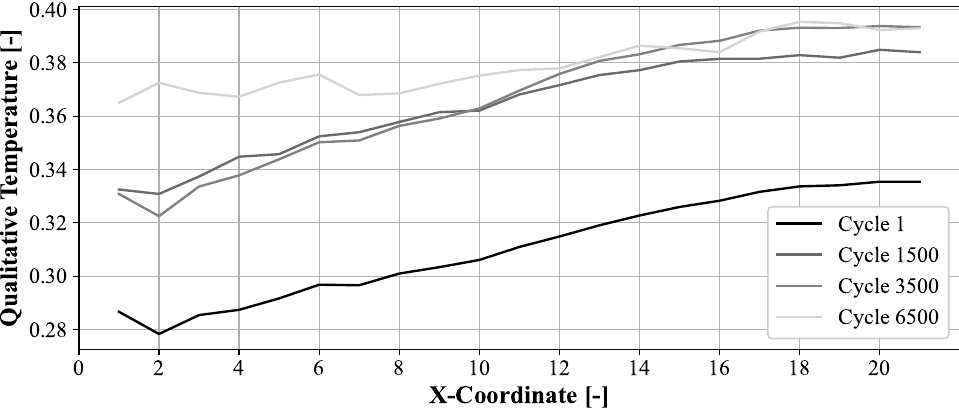
Figure 16. Change of the temperature distribution along the wire over different numbers of